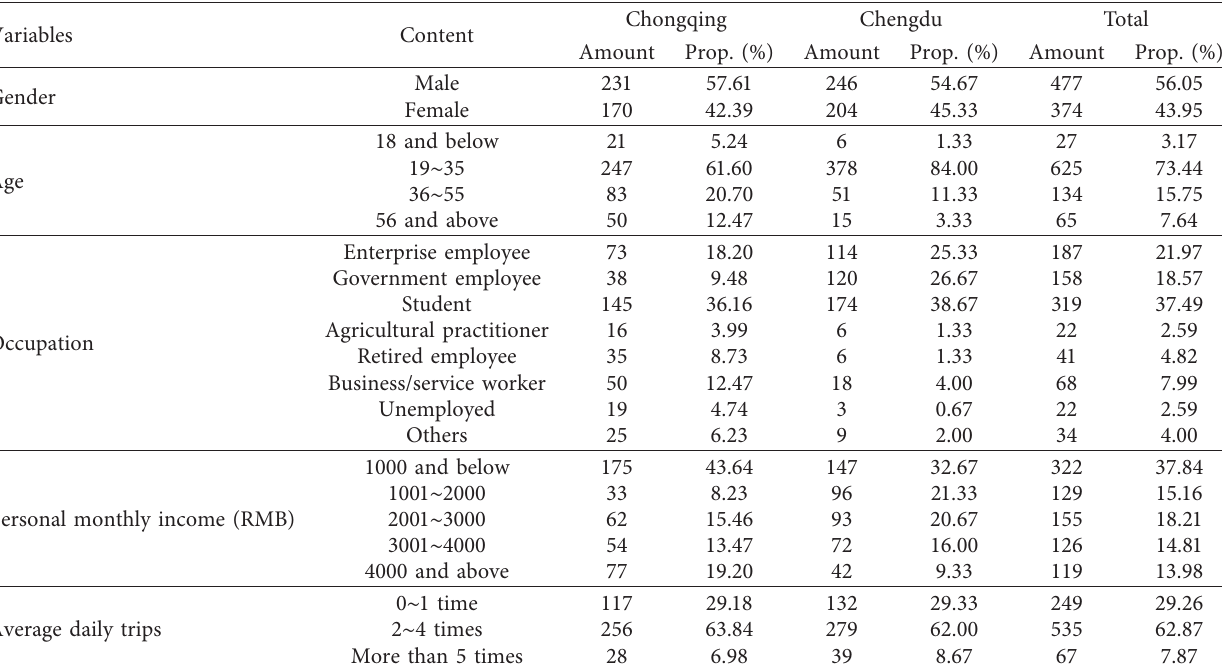
Table 2: Statistical analysis of study participants.